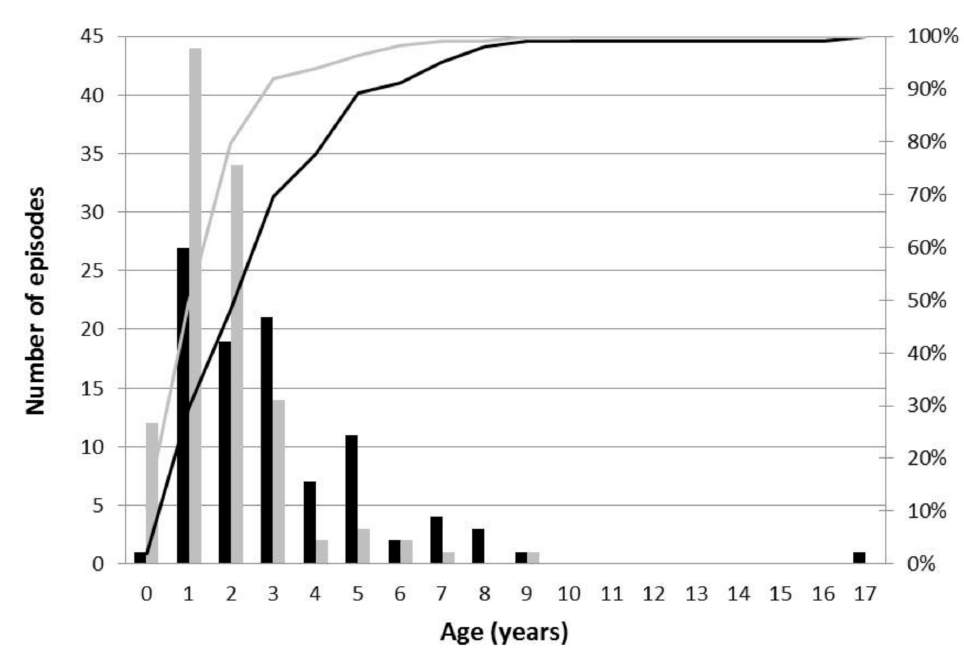
Figure 2. Number of episodes of seizures accompanied by fever along with their accumulated ratios according to the patient ages in the influenza group (black color) and in the other respiratory viruses group (gray